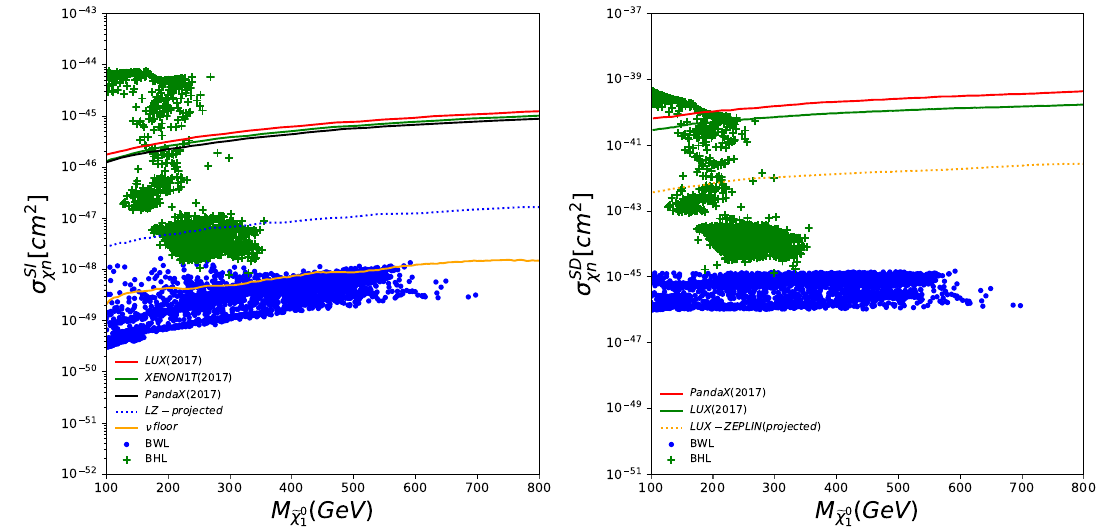
Figure 2 . Scatter plots of the samples survived the constraints (1){(5), showing the spin- independent and spin-dependent neutralino LSP-nucleon scattering cross sections. The samples in BWL and BHL scenarios are denoted by blue dots and green plus respectively. The observed 90% CL upper limits from LUX2017 [53], XENON1T-2017 [54] and PandaX-2017 (Run9+Run10) [55] and the future sensitivities from LZ-projected [56] are